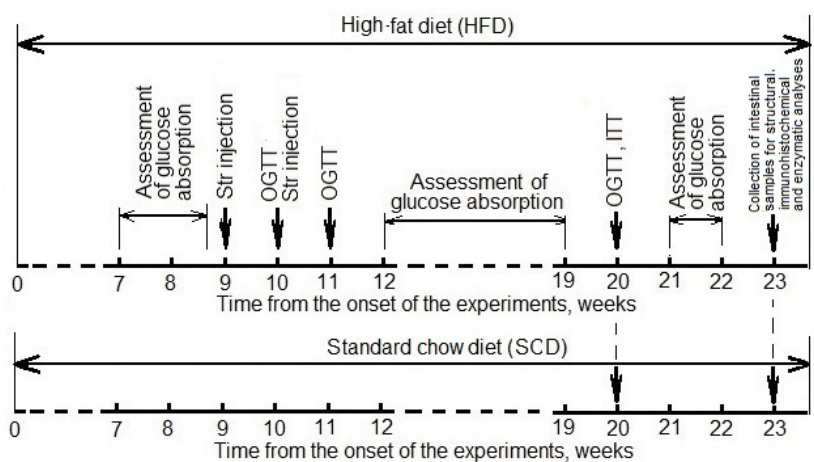
Figure 1. A design of the experiments. Str—streptozotocin; OGTT—oral glucose tolerance test, ITT—insulin tolerance test.